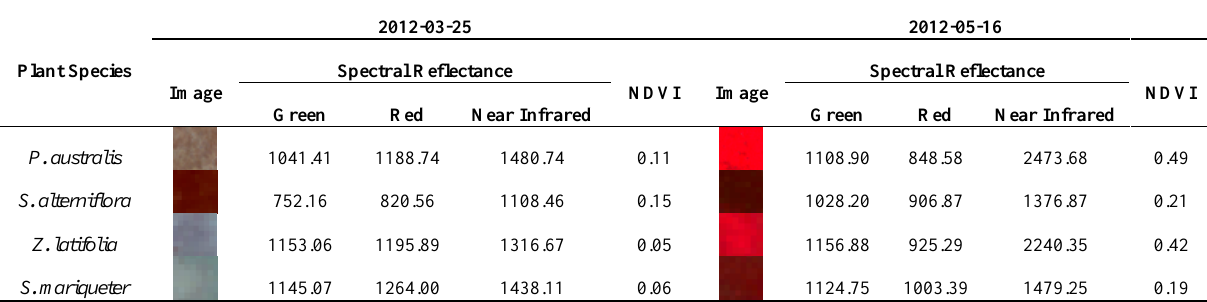
Table 3. The spectral reflectance (magnified by 10,000 times) of the four dominant plant species at Jiuduansha Wetland during two time